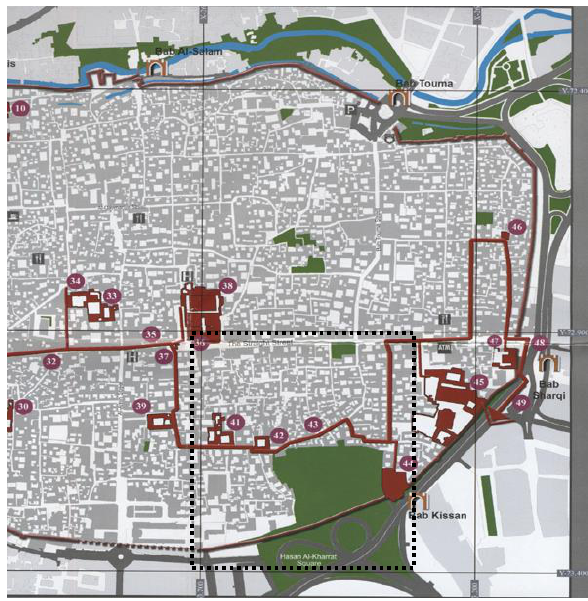
Figure 13. Itinerary in Touristic Guide, MAM,